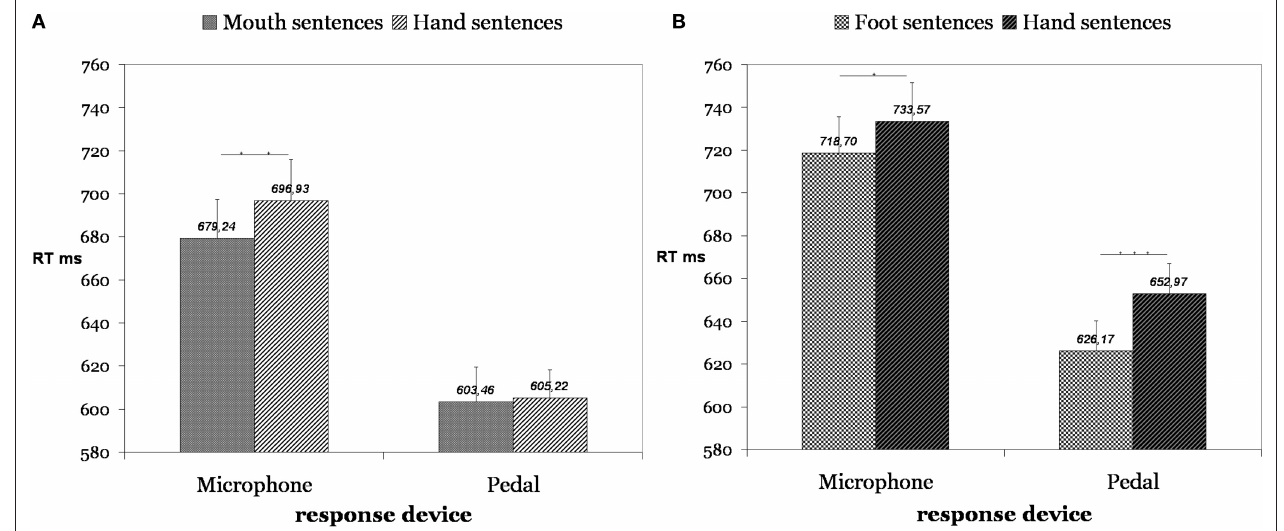
Figure 1 | Participants using the microphone responded with greater speed to “mouth sentences” than to “hand sentences” (A), p < 0.01. Symmetrically, participants who used the pedal as responding device were significantly faster for “foot sentences” than for “hand sentences” (B) , p < 0.